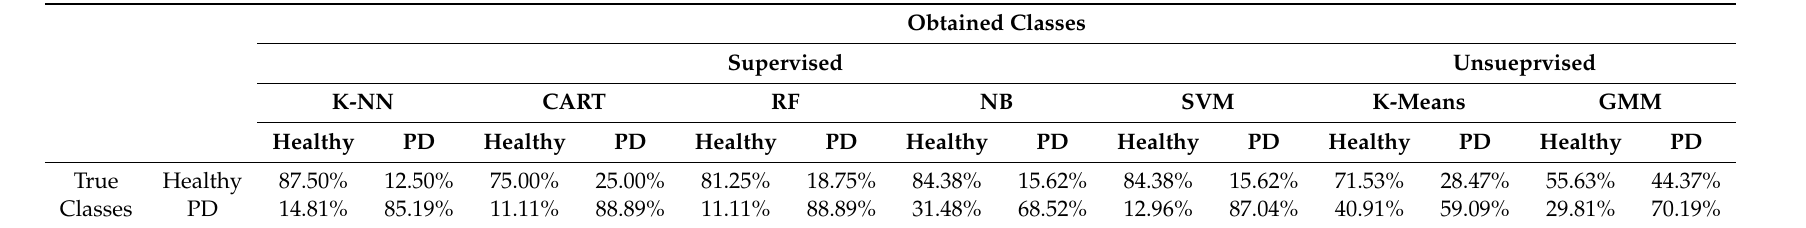
Table 8. Global confusion matrix obtained using the different classifiers in the case of the Yogev et al. sub-dataset.